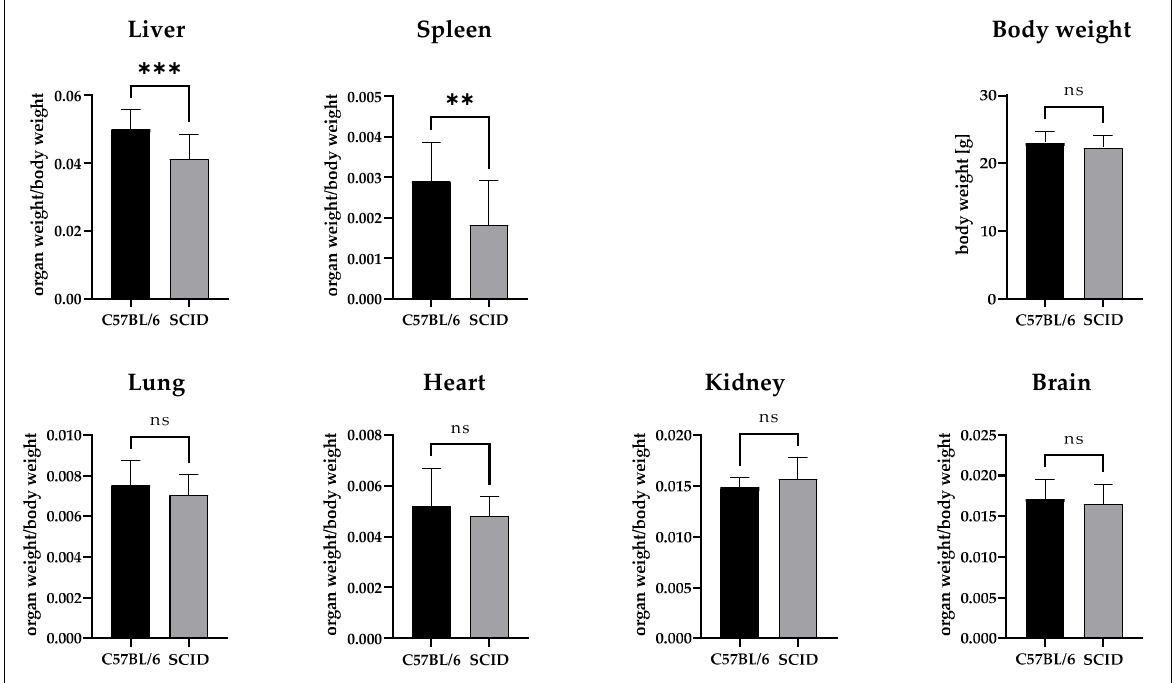
Figure 2. 89 Zr-labeling stability in human serum, 0.9% NaCl and cell culture media. Over the entire measuring period of 138 h, the labeling remained stable in all samples.